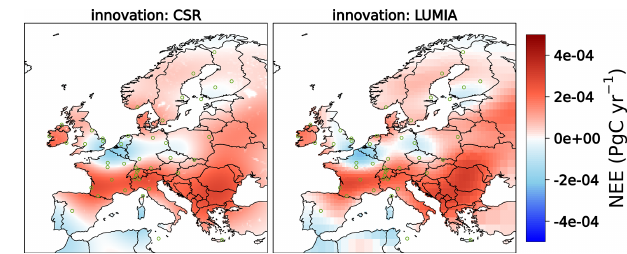
Figure 8. Innovation of fluxes calculated from CSR and LUMIA using identical uncertainties of prior flux and measurements. The uncertainty flux shape was flat and the decaying spatial correlation was fit to a Gaussian function with 500km scale. FLEXPART and TM5 models were used in this